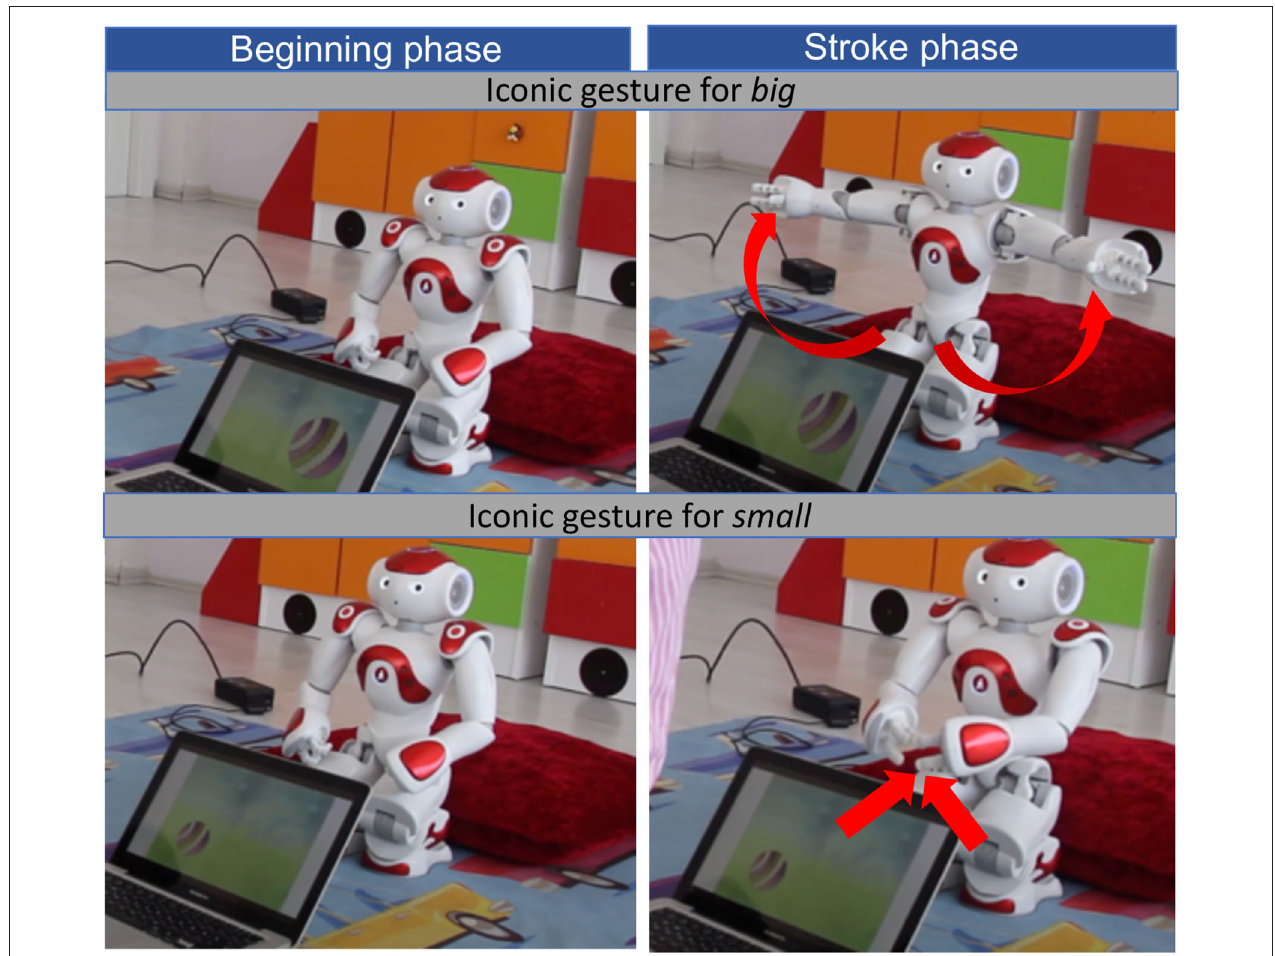
FIGURE 2 | Example for phases (beginning, stroke) of iconic gestures when teaching the word big (top image) and small (bottom image).